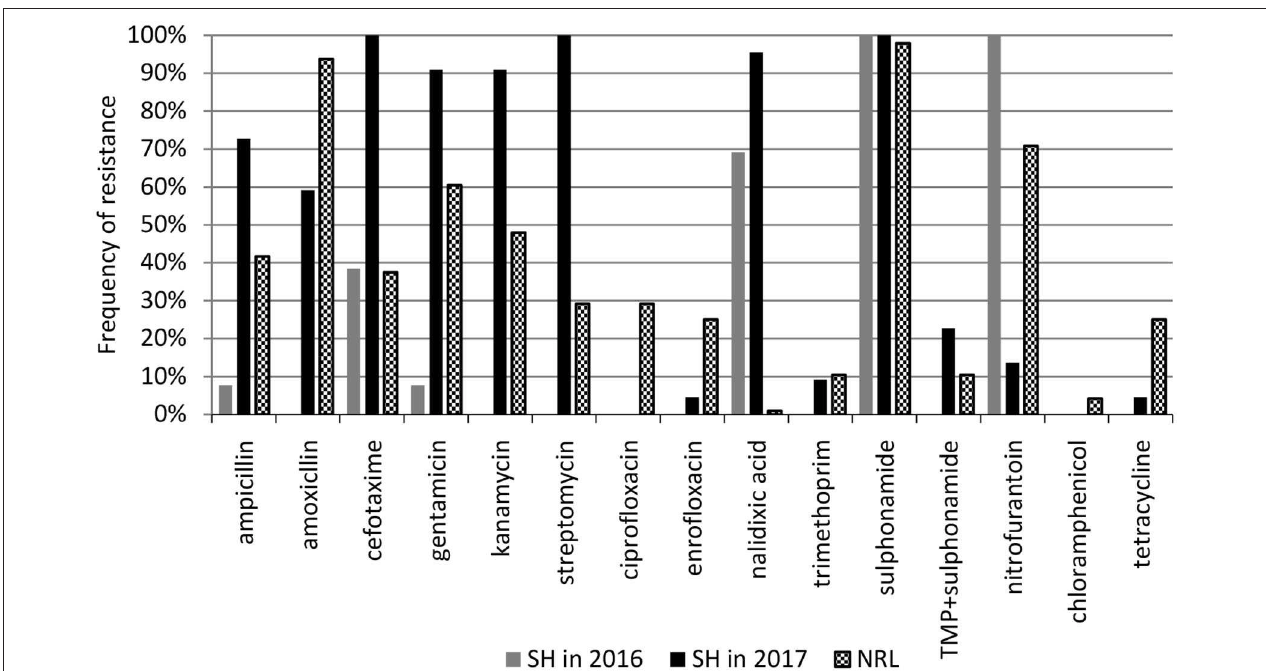
FIGURE 2 | Frequency of antibiotic resistance among aEPEC strains. SH, slaughterhouse, NRL, National Reference